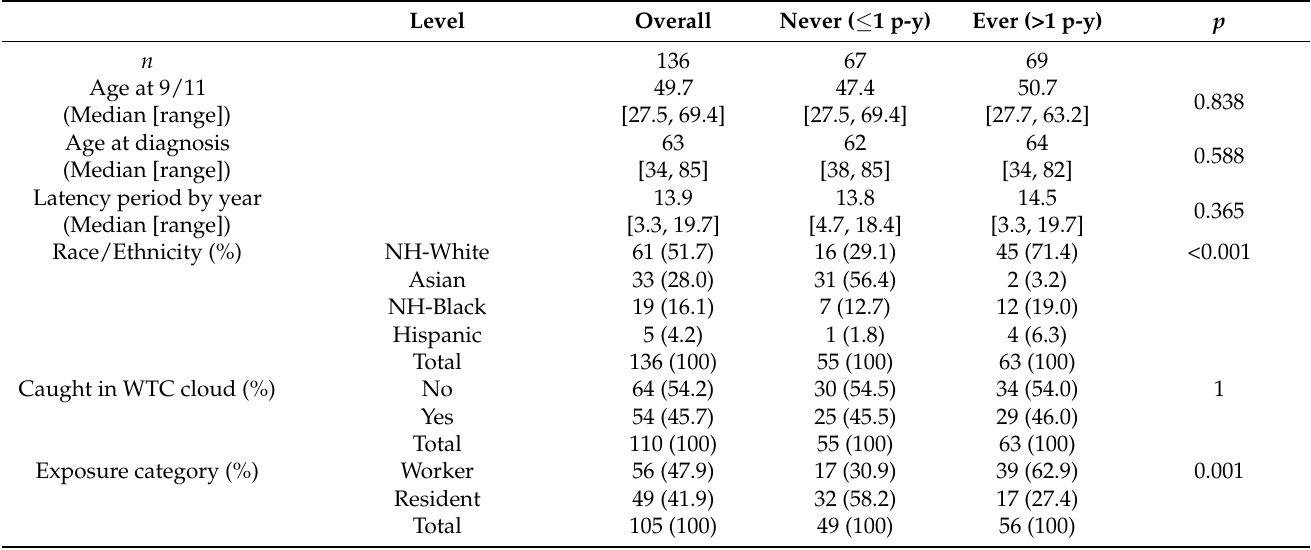
Table 1. Characteristics of women lung adenocarcinoma patients in the World Trade Center Environ- mental Health Center (WTC EHC) with available smoking